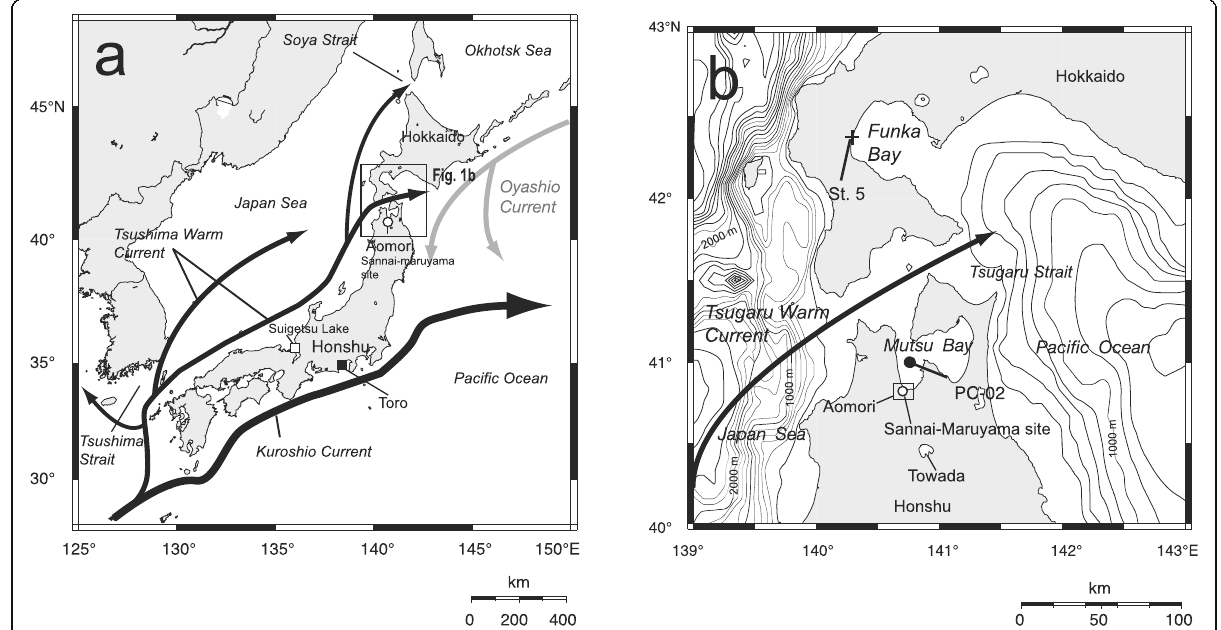
Fig. 1 a Map of the Japan Sea and the North Pacific around the Japanese Islands, including Honshu and Hokkaido. The paths of the Tsushima, Oyashio, and Kuroshio Currents are indicated. The route of the Kuroshio Current follows Jian et al. (2000). Honshu is the central and largest of the four main islands of Japan while Hokkaido is the second largest. The location of the Toro site (solid square) and Suigetsu lake (open square), central Japan, is also shown. b Locations (solid circle) of the core KT05-7 PC-02 site (41° 00 ′ N, 140° 46 ′ E; water depth, 61 m) and the Sannai- Maruyama archeological site (open circle). Bathymetric isolines are at 200 m depth intervals. The location (cross) of the St. 5 site (42° 23 ′ 59.377 ″ N; 140° 24 ′ ) in Funka Bay is also shown. Sannai-Maruyama was designated a Special National Historical Site in Japan in 2000 (Sannai